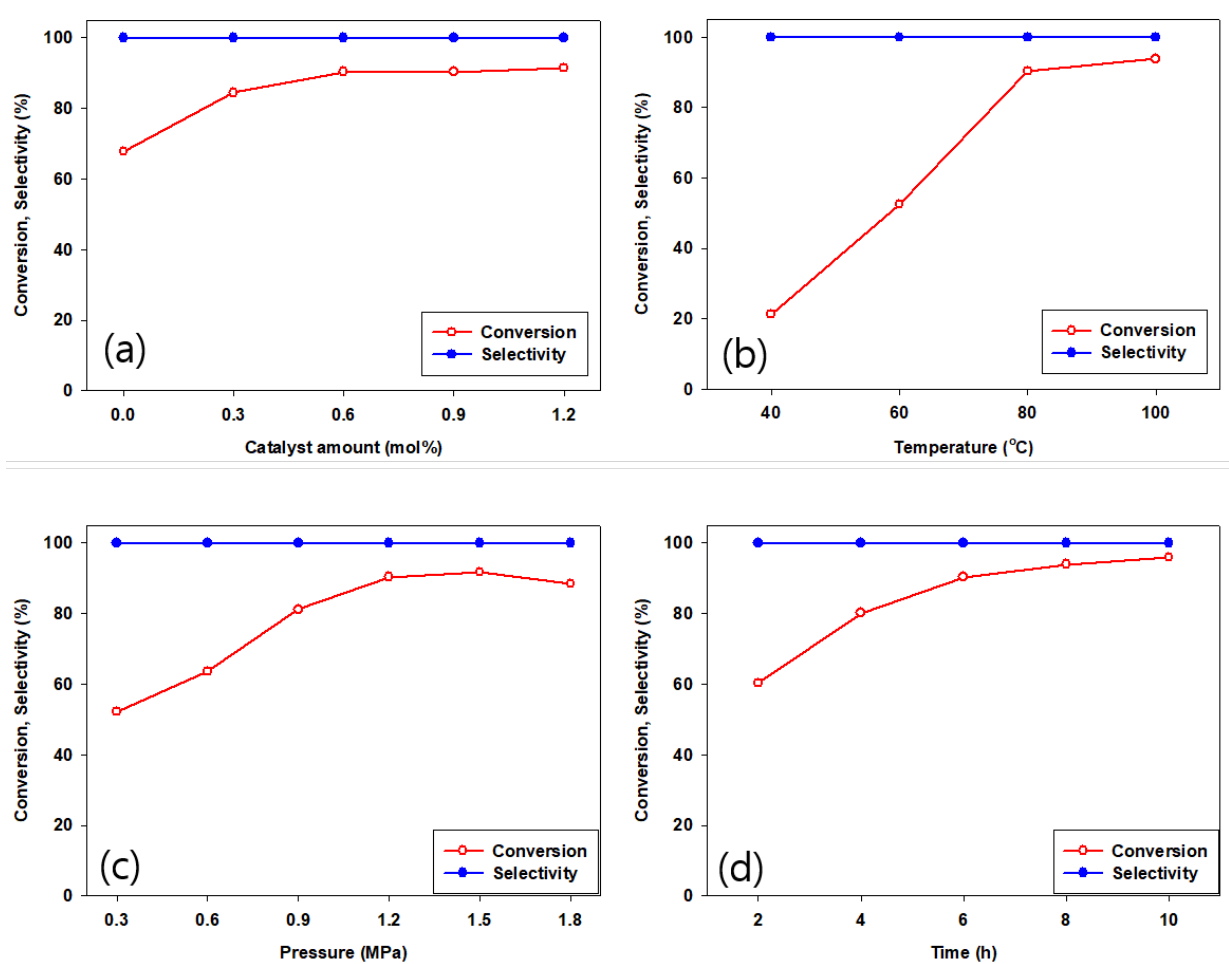
Figure 8. Effect of various reaction parameter on the cycloaddition of CO 2 and ECH with CPM-200-In/Mg catalyst ( a ) catalyst amount (80 °C, 6 h, 1.2MPa CO 2 ), ( b ) temperature (0.6 mol%, 6 h, 1.2MPa CO 2 ), ( c ) CO 2 pressure (0.6 mol%, 80 °C, 6 h), and ( d ) time (0.6 mol%, 80 °C, 1.2MPa CO 2 ).